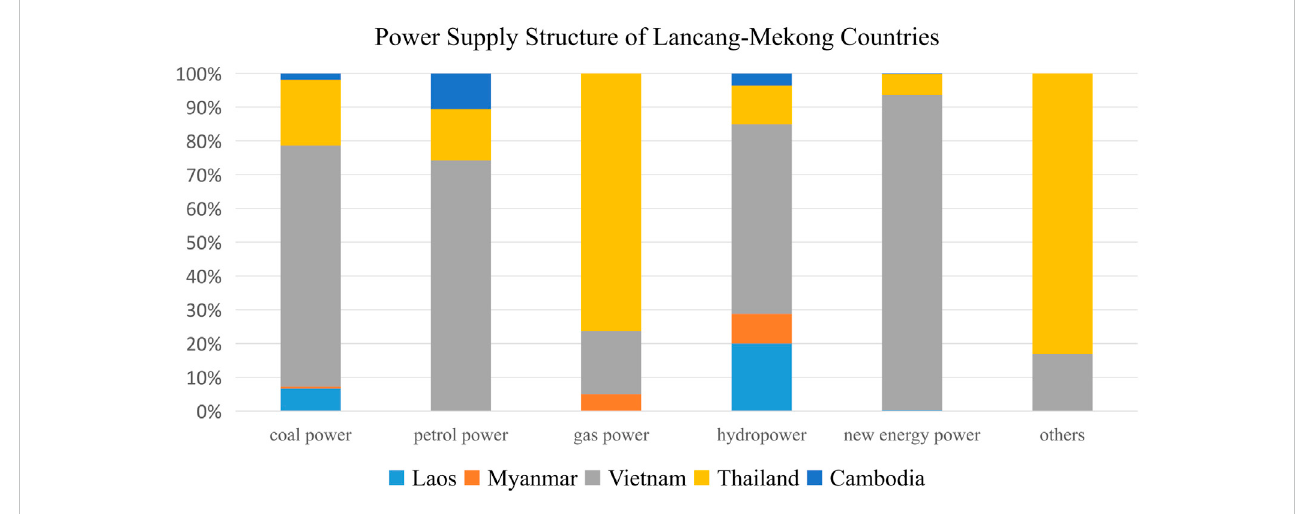
FIGURE 1 Power supply structure of Lancang- Mekong countries.